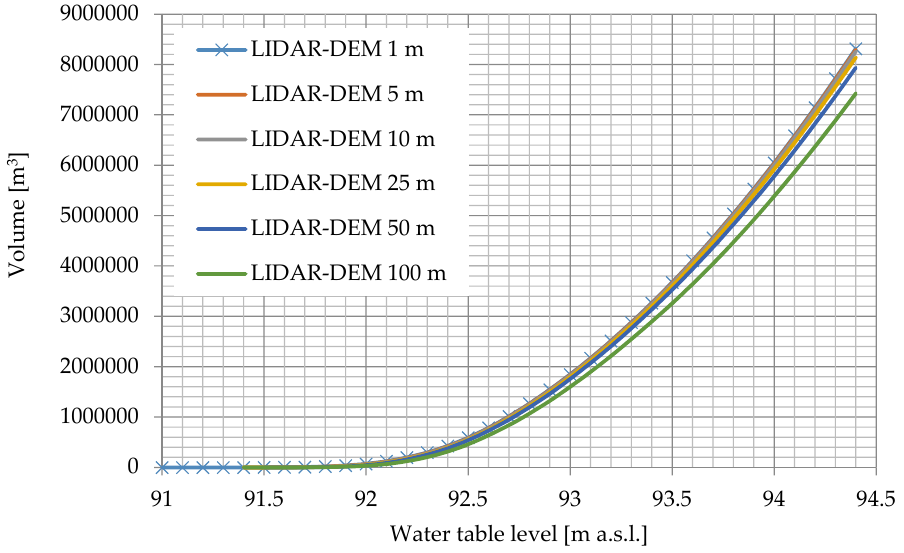
Figure 5. Comparison of the polder volume depending on the resolution of the LIDAR-DEM.